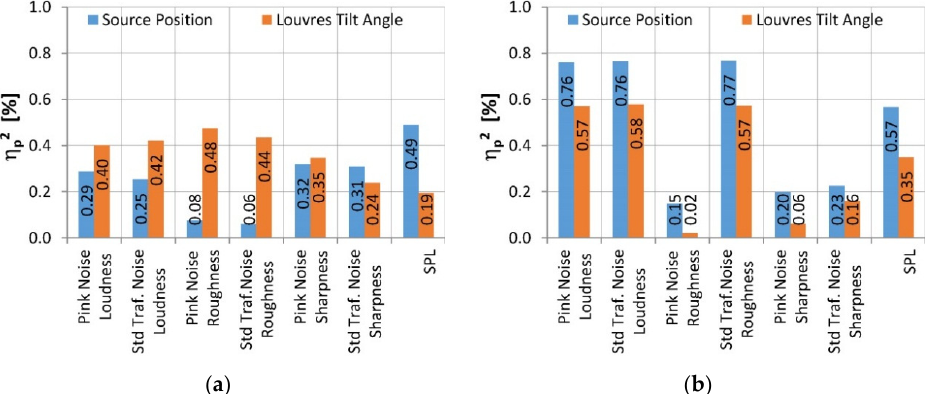
Figure 11. The effect of size for the group mean differences; partial eta squared factor for the mean differences referred to the variances of Loudness Levels, Roughness, Sharpness and SPL: ( a ) traditional louvres; and ( b ) sound absorbing louvers.